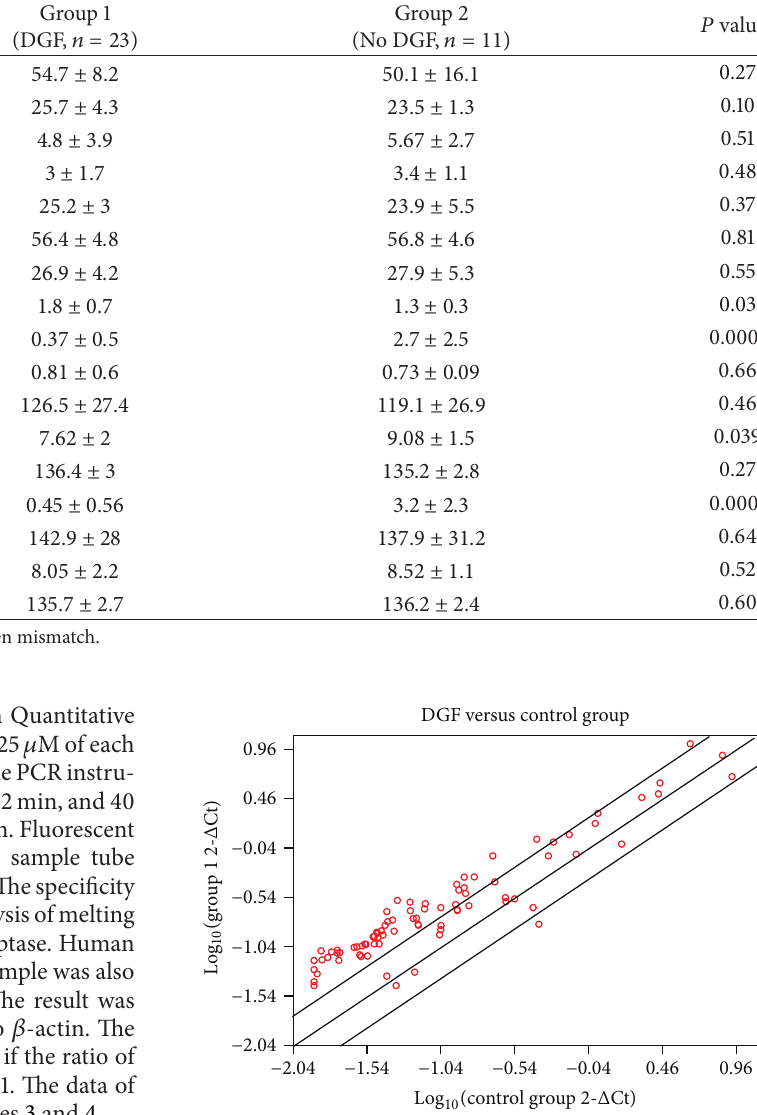
Figure 1: Scatter plot analysis of gene expression profiling on expanded criteria of kidney transplant patients. cDNA microarray analysis on 16 RNA samples from kidney transplant patients. After normalization on housekeeping genes, the final scores of each of the genes of all arrays were compared with those from the control array. ThescatterplotwasacquiredasdescribedinMaterialsandMethods. The 𝑦 -axis represents log scores from DGF patients (group 1) and the 𝑥 -axis represents log scores from no DGF patients (group 2). Eachsymbolrepresentsonegene.Thosegeneoutsidetheboundaries represent 2-fold higher or lower expressed in DGF